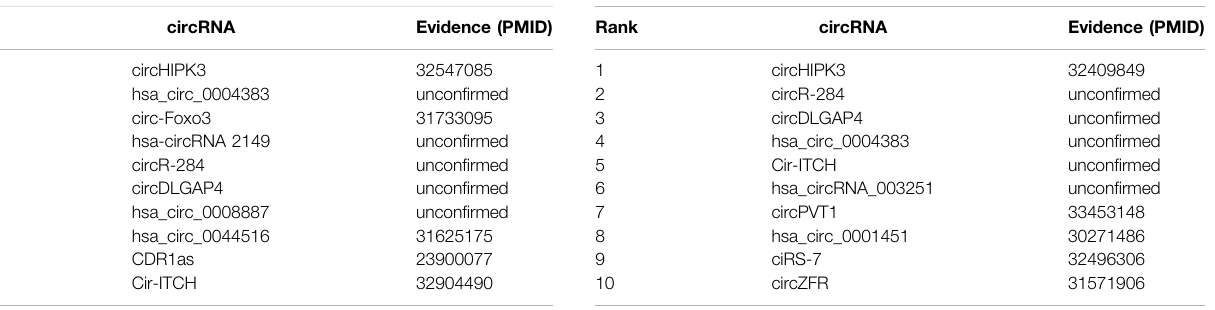
TABLE 6 | Top 10 candidate circRNAs related to clear cell renal cell